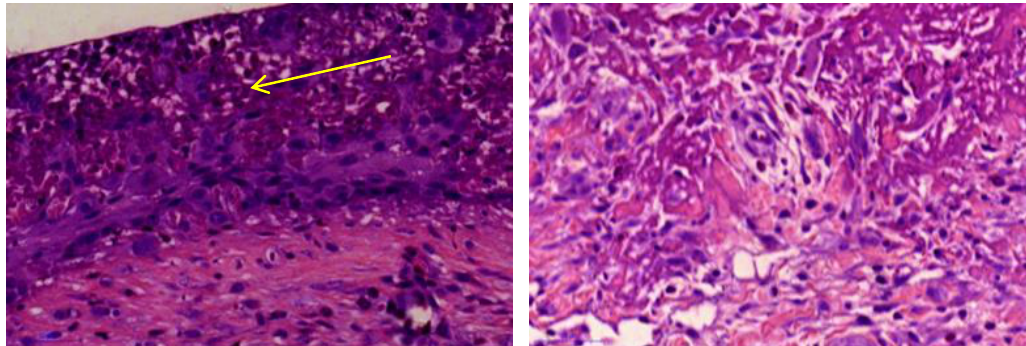
Figure 3: Microphotograph of study group treated with gingival sulcular irrigation of 50 μL/kg of distilled water after three days showing a moderate inflammatory reaction, ulcerative sulcular epithelium (arrow). H&E x20,